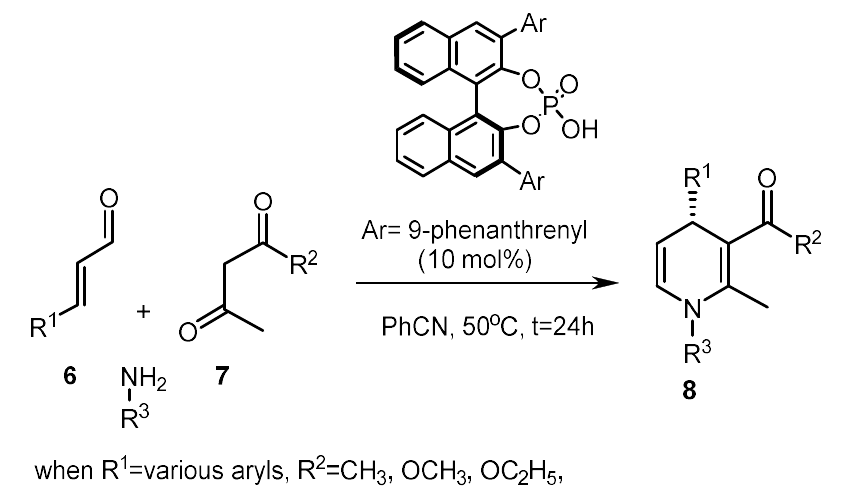
Scheme 4. Chiral BINOL-derived phosphoric acid catalysed synthesis of 1,4-DHPs 8 [65].